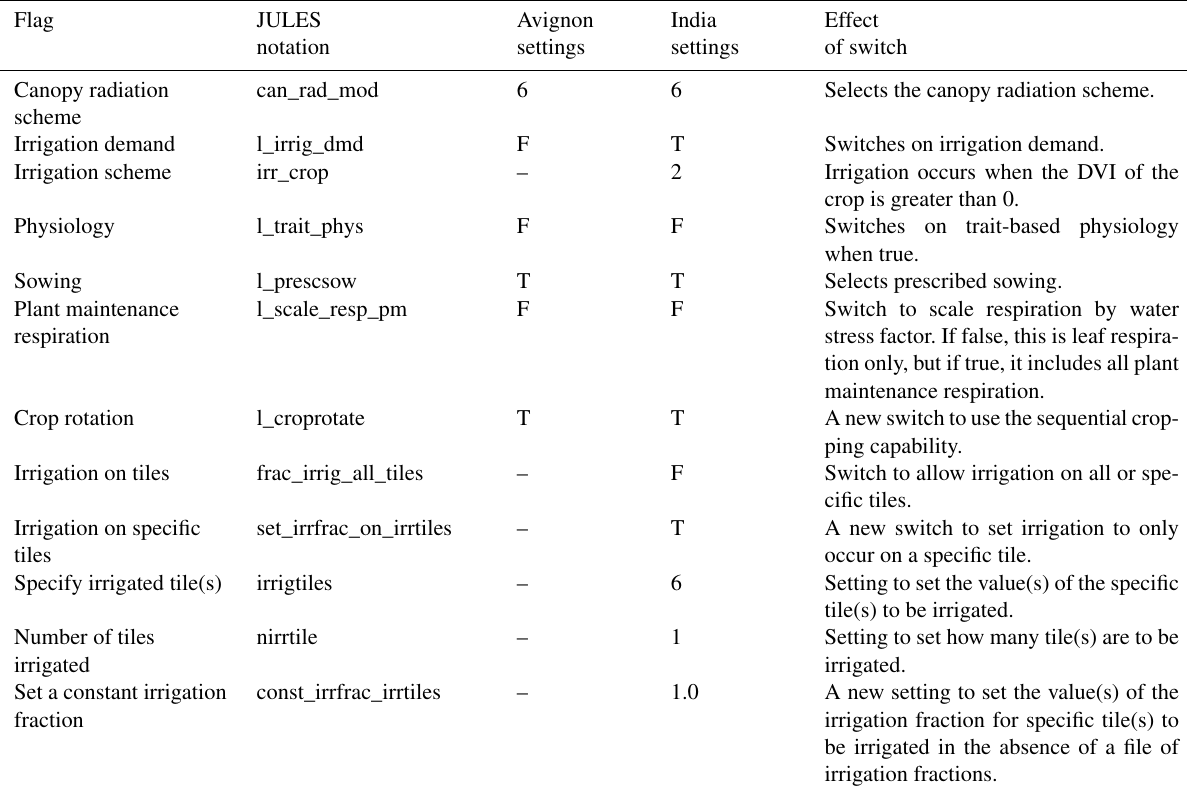
Table 1. JULES flags used that are new or different from those in Osborne et al. (2015). Flag JULES Avignon India Effect notation settings settings of switch 6 Selects the canopy radiation